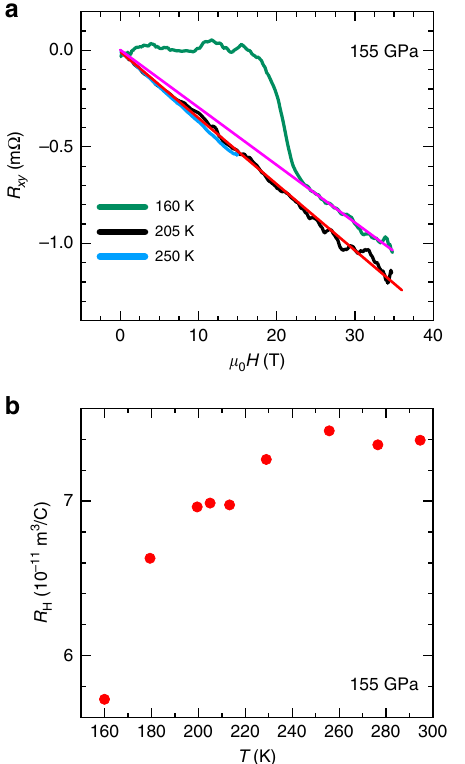
Fig. 2 Hall-effect as a function of the fi eld and for several temperatures. a Hall resistance R xy as a function of the magnetic fi eld μ 0 H at a temperatures T = 160, 205, and 250 K for 155 GPa sample. For the trace collected at 160 K, the sample remains superconducting below 20 T, but recovers its linear-in- fi eld behavior in the normal state above H c2 . Magenta and red lines are linear fi ts to the 160 K and 205 K curves, respectively. b Normal state Hall coef fi cient R H as a function of T for the H 3 S sample pressurized under 155 GPa. Source data are provided as a Source Data fi le